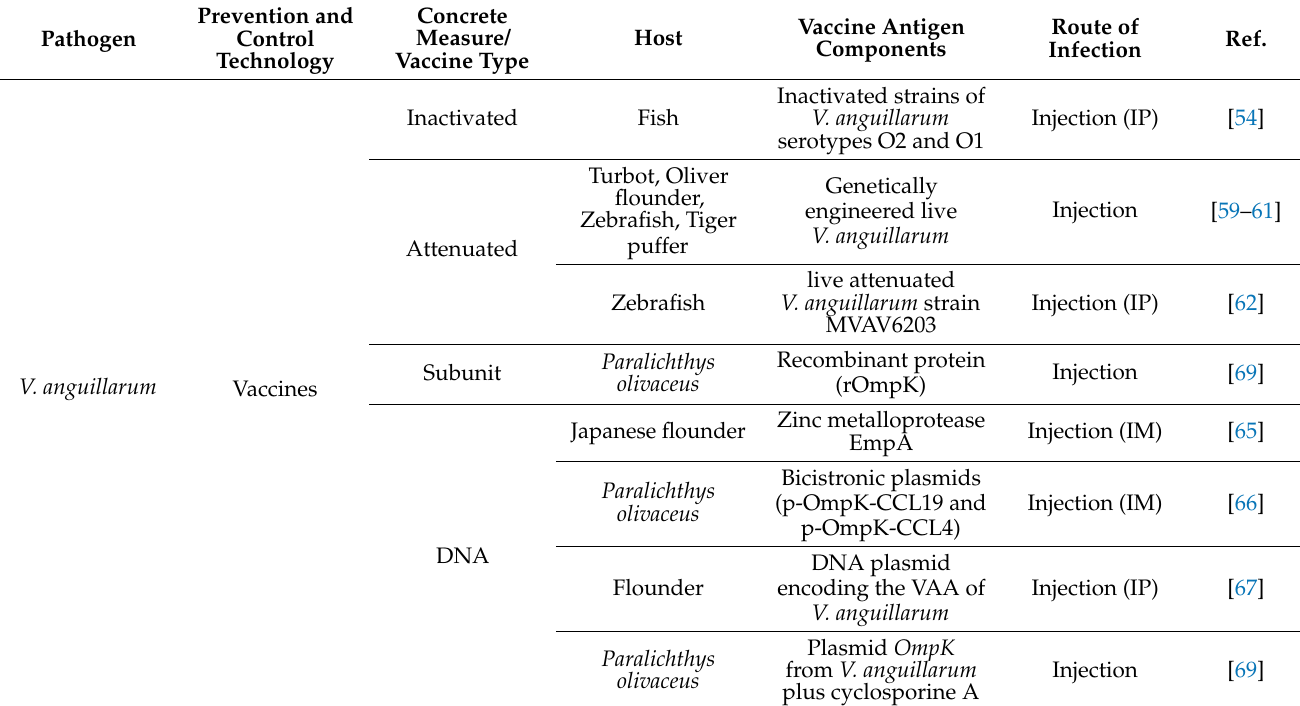
Table 5. Control and prevention strategies of V. anguillarum. NR: Not Relevant, None: the method has not been tested in vivo or relevant data has not been